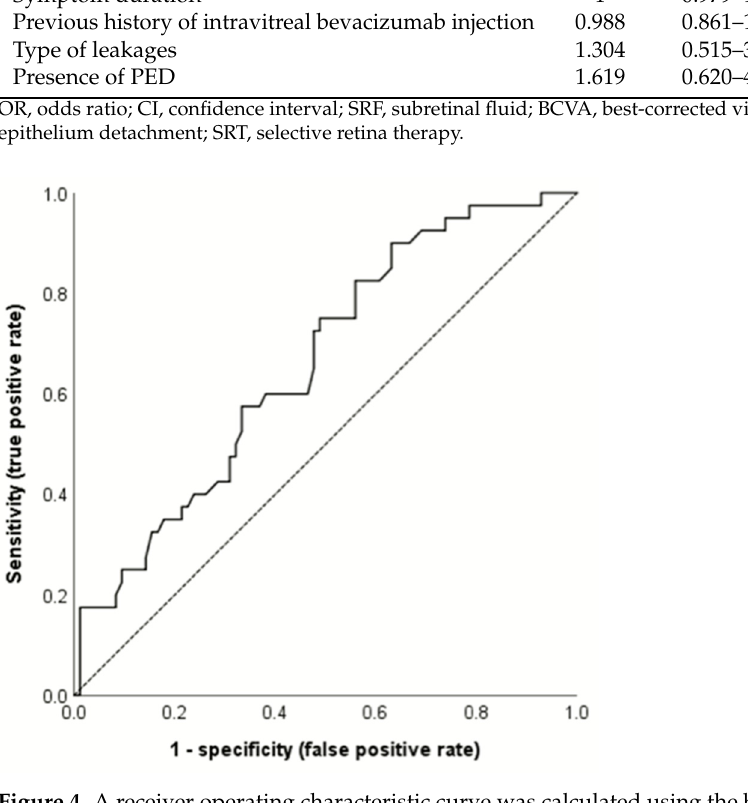
Figure 4. A receiver operating characteristic curve was calculated using the baseline subretinal fluid (SRF) height for predicting the need for retreatment. The optimal cutoff value (Youden index) was determined as an SRF height of 133.5 μ m (sensitivity 82.5%, specificity 44%, area under the receiver operating characteristic curve 0.661, p = 0.004). Table 6. Multiple logistic regression analysis of factors associated with need for SRT retreatment in patients with chronic central serous chorioretinopathy.